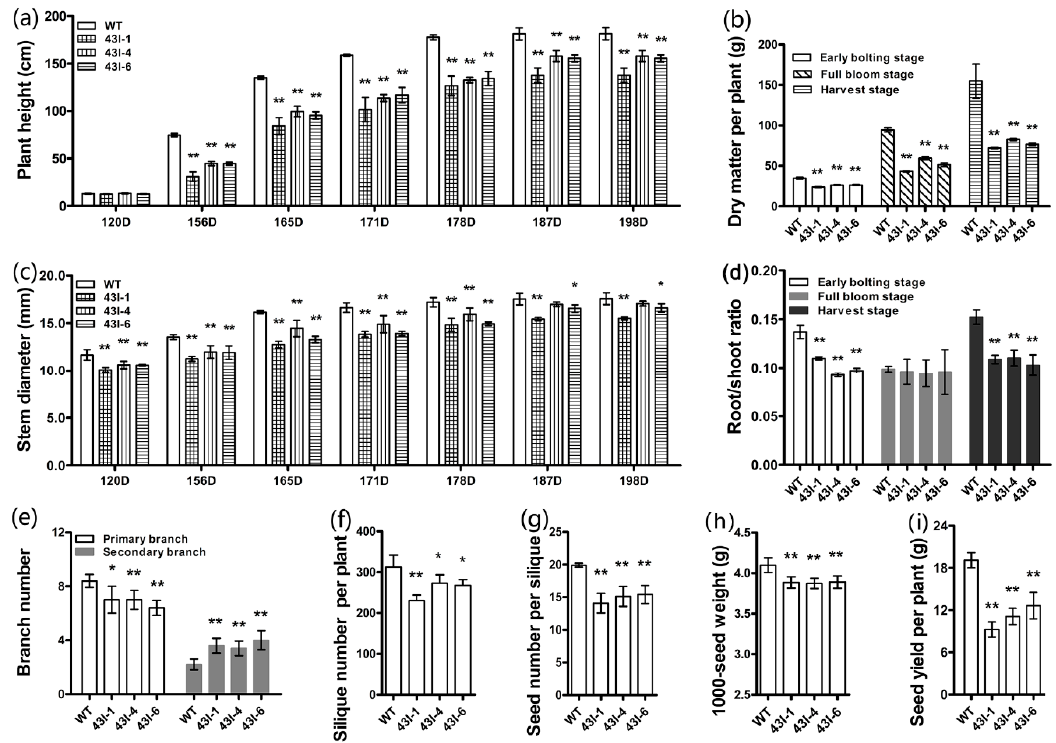
Figure 2. Phenotypic changes of BnMYB43I transgenic plants. ( a ) The development dynamic of the plant height. ( b ) The dry matter of plant. ( c ) The development dynamic of the main stem diameter. ( d ) The root/shoot radio. ( e ) Number of branches. ( f ) Number of silique at the mature stage (191D). ( g ) Number of seed per silique. ( h ) The weight of 1000-grain of oilseed rape. ( i ) The weight of the seed yield per plant. Values are means ± SD from three biologically independent repeats. Asterisks indicate significant or extremely significant differences from the control (*, 0.01 ≤ p < 0.05; **, p < 0.01) using one-way ANOVA.